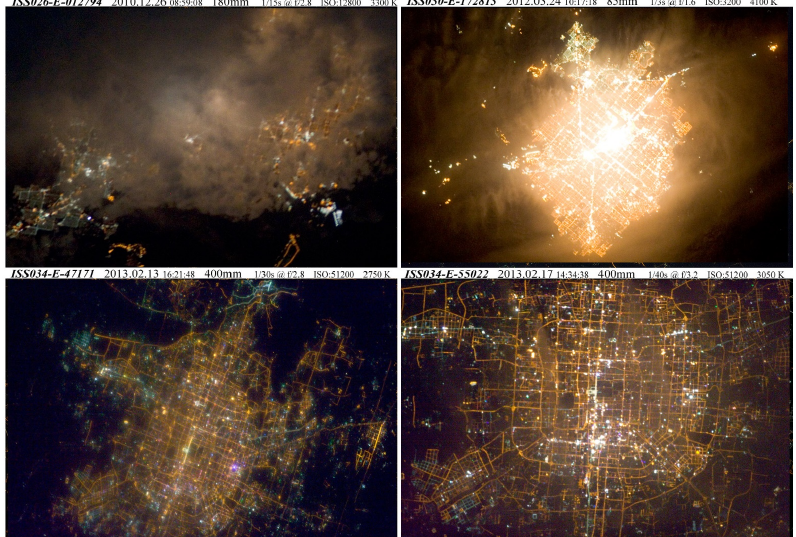
Figure 2. Spatially variable atmospheric scattering effects for Las Vegas ( top ) and Beijing ( bottom ). Translucent clouds over Las Vegas are more conspicuous because of overglow effects extending beyond the periphery of the light sources, as well as the longer exposure of the 2012 image. Spatially varying sharpness within the lighted area of Beijing is more subtle but, nonetheless, distorts both the brightness and spatial extent of individual light sources. Compare the sharpness of these Beijing images with the 2016 and 2020 shots shown in Figure 1. All 4 Beijing images were taken with the same 400 mm lens.